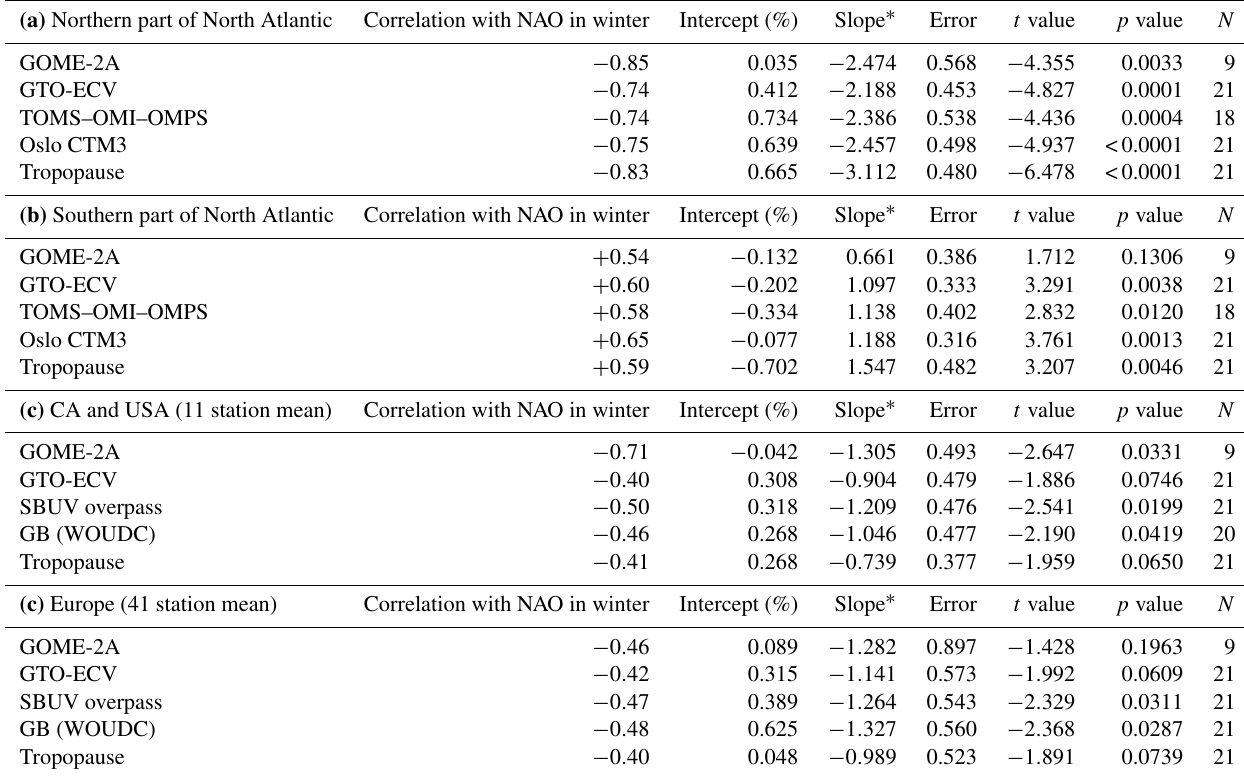
Table 8. Statistics of the comparisons between total ozone, tropopause pressures, and NAO index in winter (DJF mean) for (a) the north- ern part of North Atlantic (35–50 ◦ N, 20–50 ◦ W), (b) its southern part (15–27 ◦ N, 30–60 ◦ W), (c) 11 stations in Canada and USA, and (d) 41 stations in